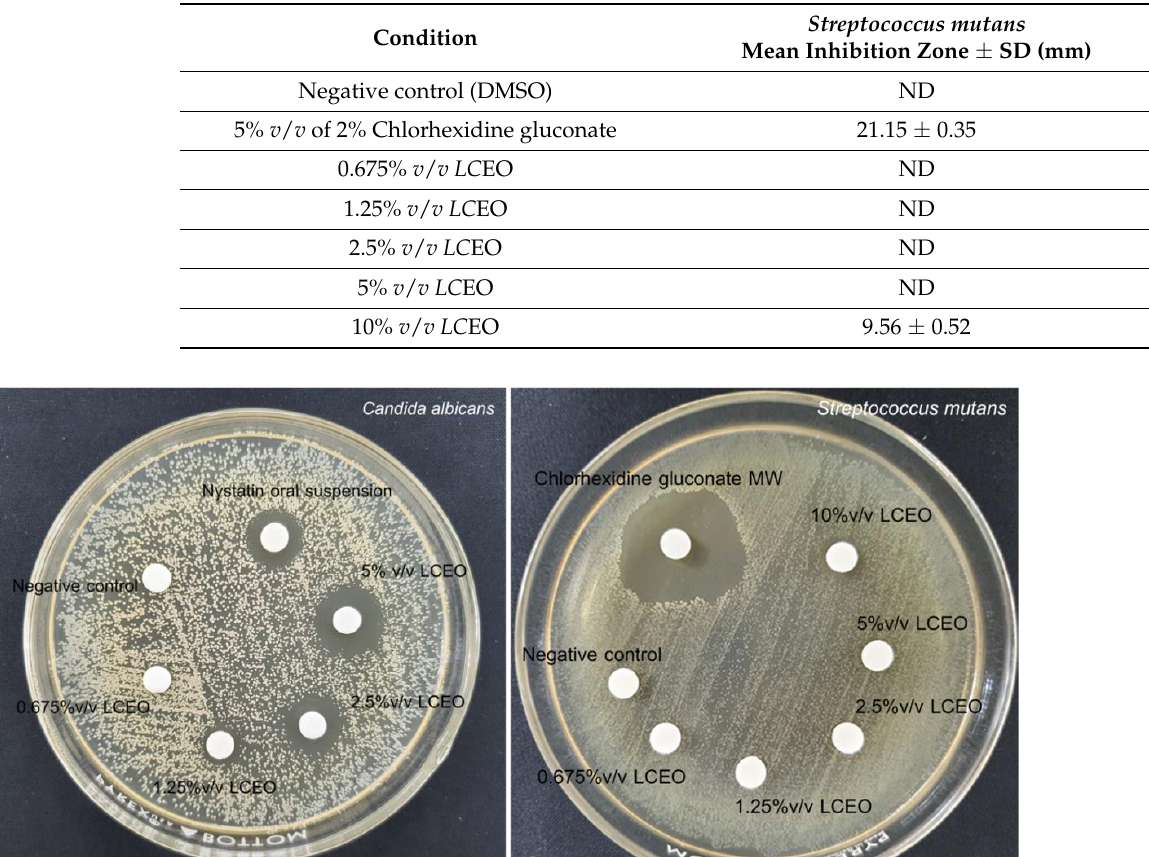
Table 3. Mean inhibition zone ± SD ( n = 5) of different concentrations of LC EO against S. mutans. Inhibition zone less than 6 mm was defined as not detected (ND).